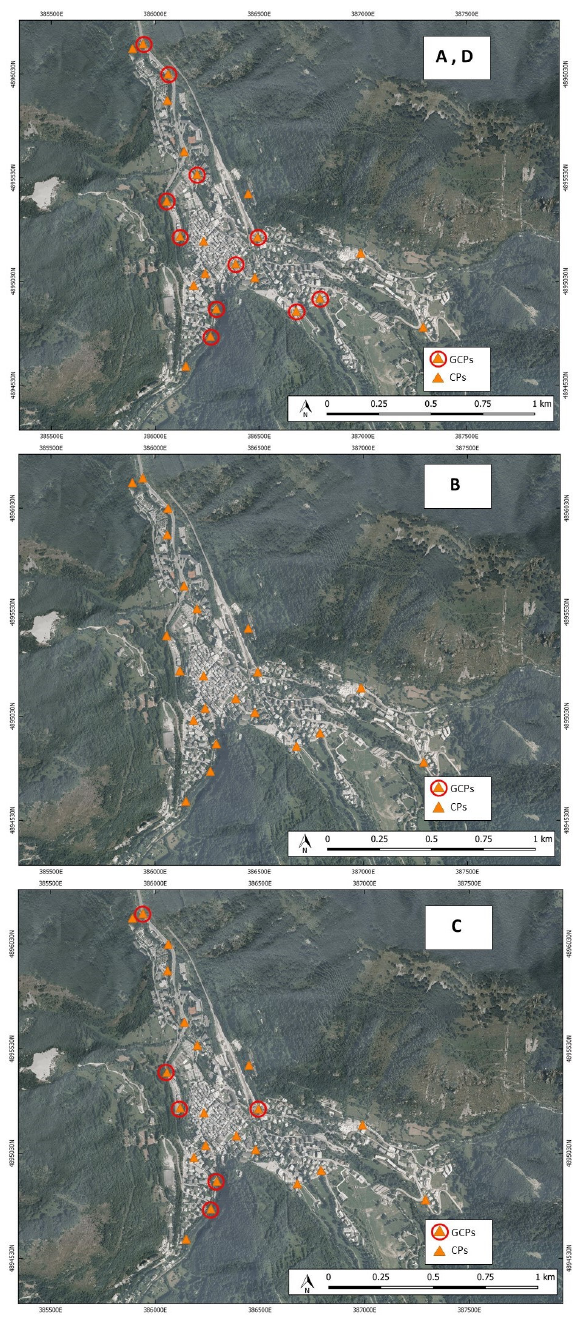
Figure 8. GCPs/CPs configuration for the different processing approaches in a single solution (strategy 2)